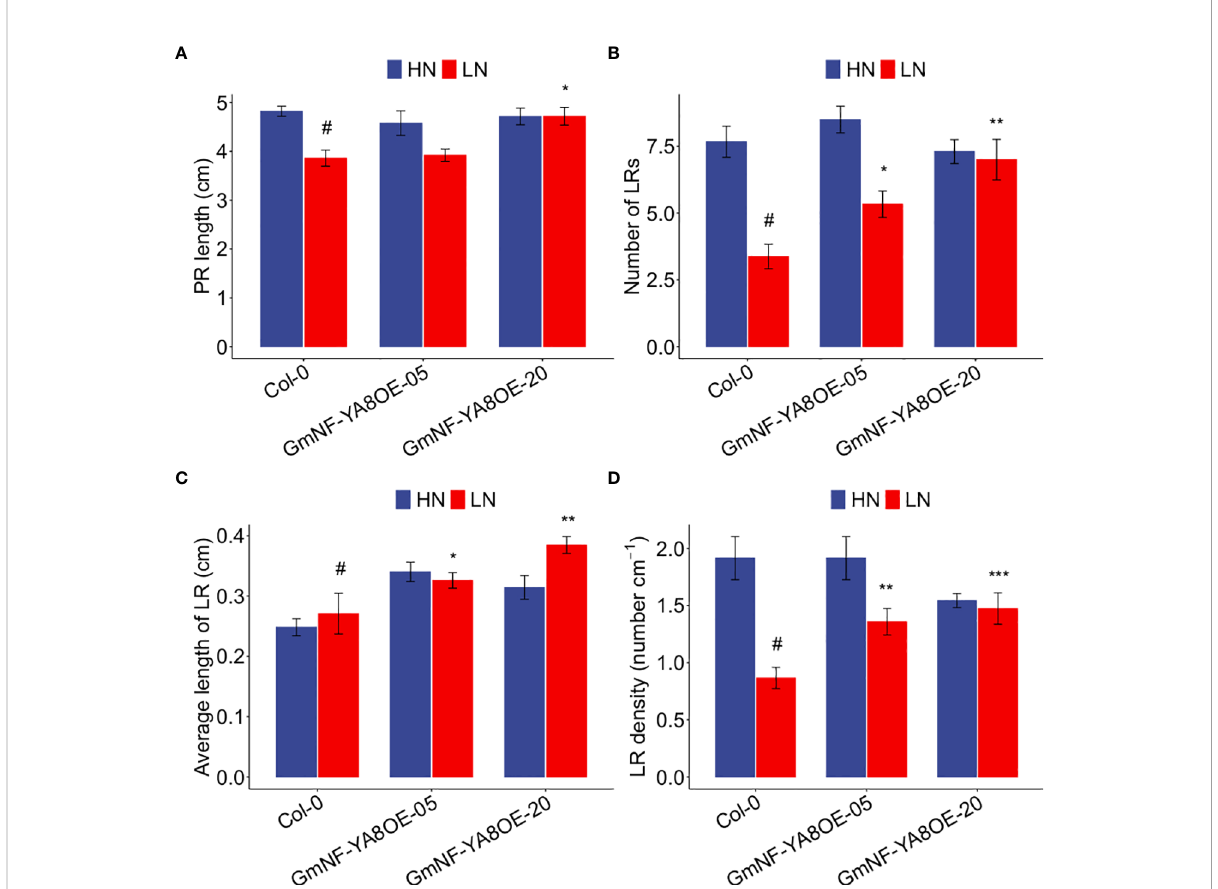
FIGURE 11 Ectopic expression of GmNF-YA8 increases number of lateral roots (LRs), average length of fi rst-order LRs, and LR density in low N. (A) PR length; (B) LR number; (C) average length of fi rst-order LRs; (D) LR density. Results are means ± SE from three independent experiments. Student ’ s t -test was used to assess the differences between Col-0 and the transgenic lines GmNF-YA8OE-05 and GmNF-YA8OE-20 (* P < 0.05; ** P < 0.01; *** P < 0.001; #, the